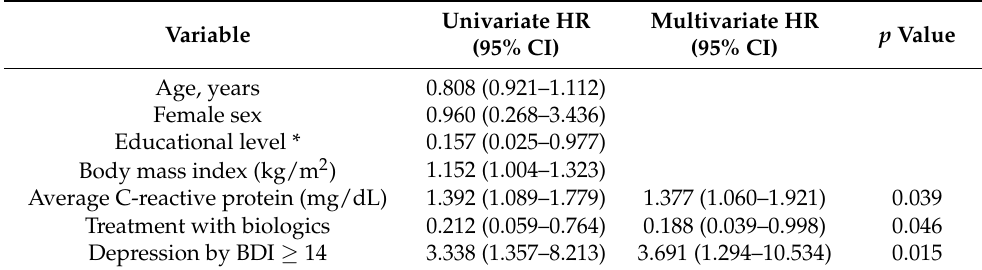
Table 4. Univariate and multivariate logistic regression of the characteristics of JIA associated with cognitive